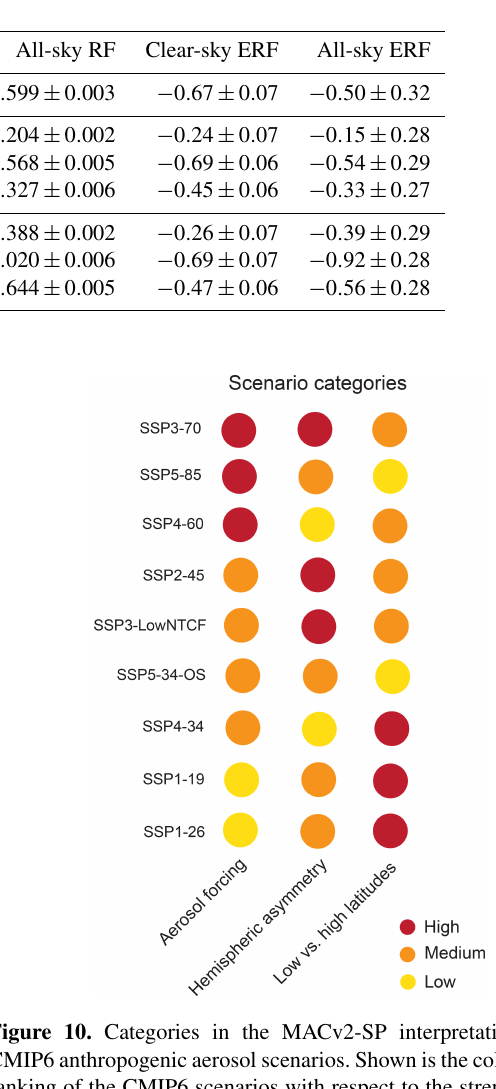
Table 3. Mid-2090s anthropogenic aerosol SW (E)RF at TOA from MACv2-SP as long-term averages ± year-to-year standard deviation in Wm − 2 .